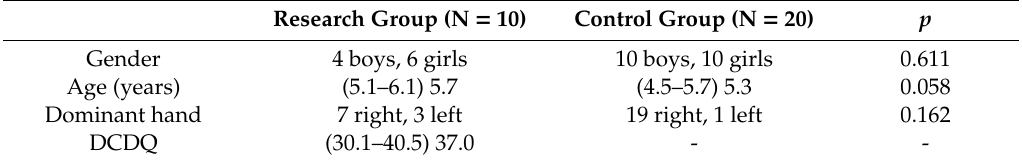
Table 1. Personal characteristics of the participants, and the Developmental Coordination Disorder Questionnaire (DCDQ) score of the research group. Quantitative data are presented as median and interquartile